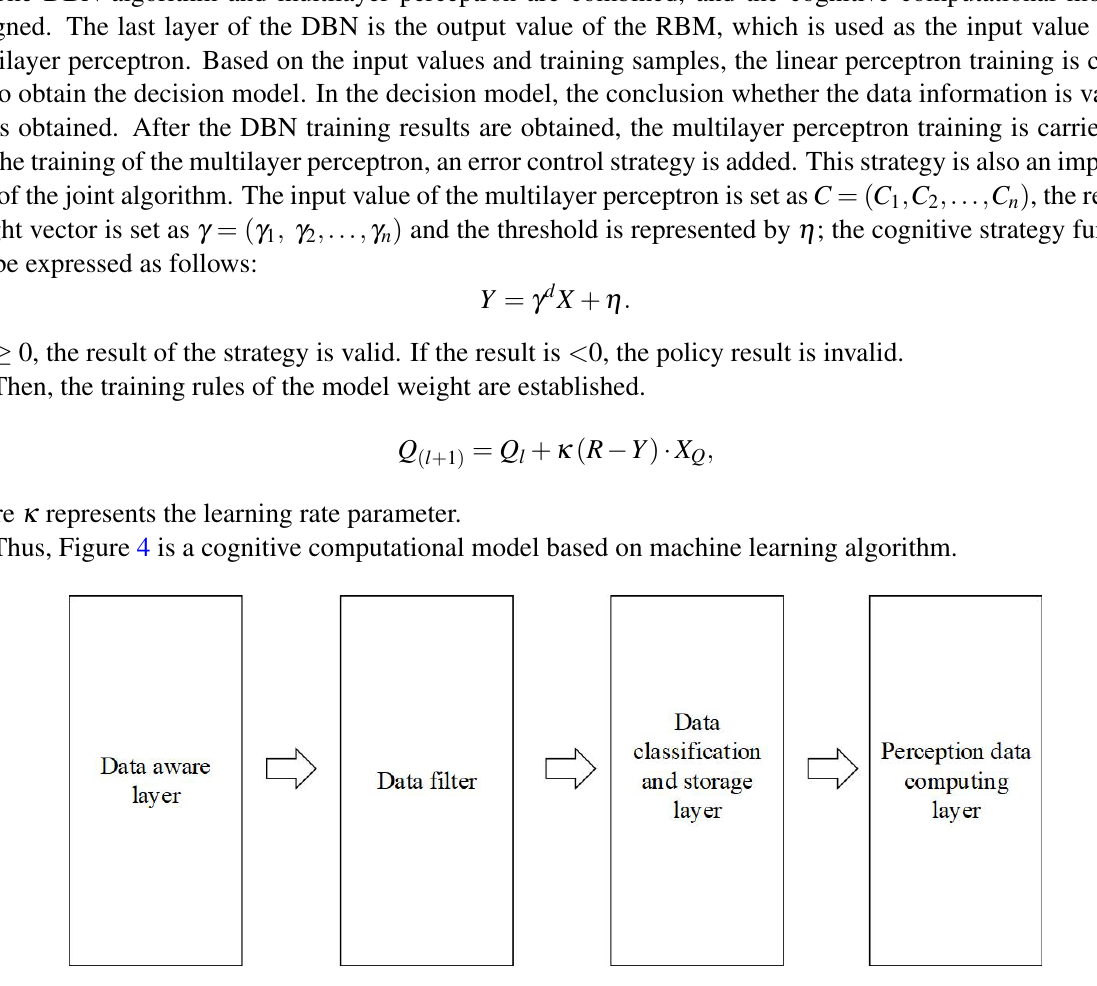
Fig. 4 Cognitive computational model based on machine learning